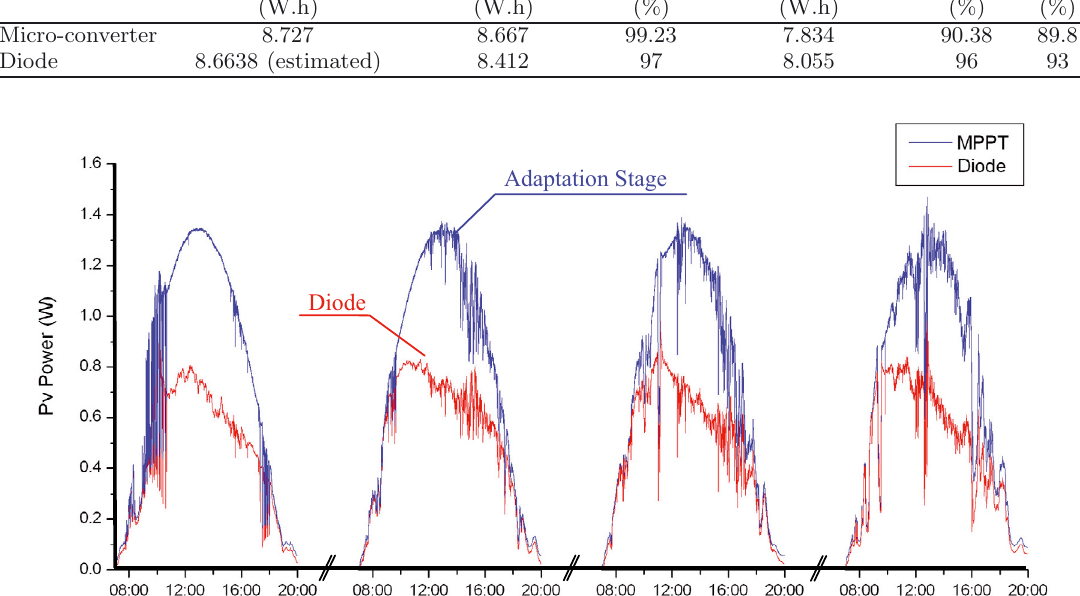
Fig. 20. Four day PV power acquisitions for 2 different architectures of power management systems.